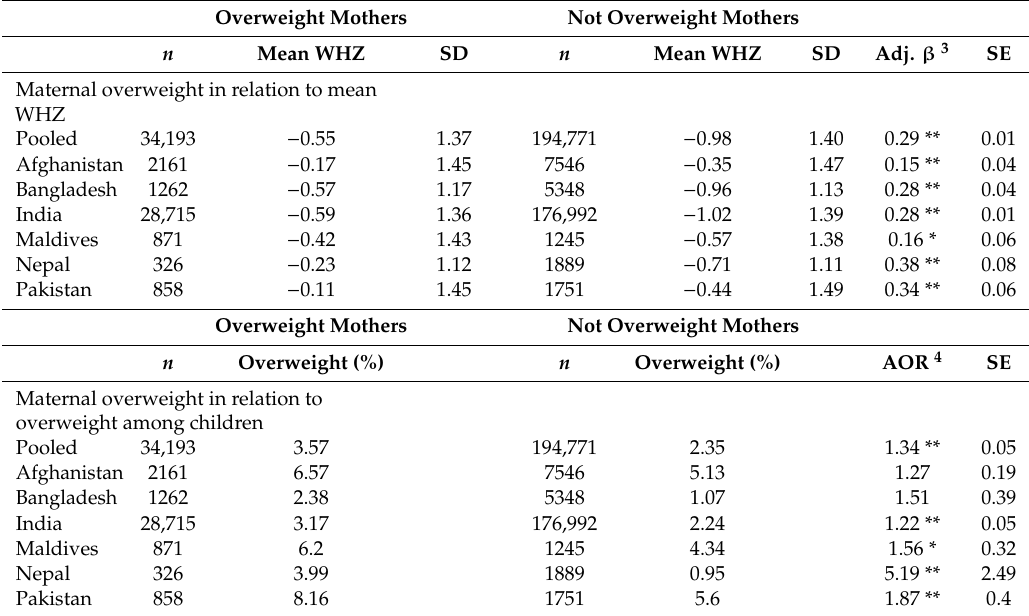
Table 2. Child weight-for-height z -score (WHZ) and prevalence of overweight 1 among children with mothers who are overweight 2 or